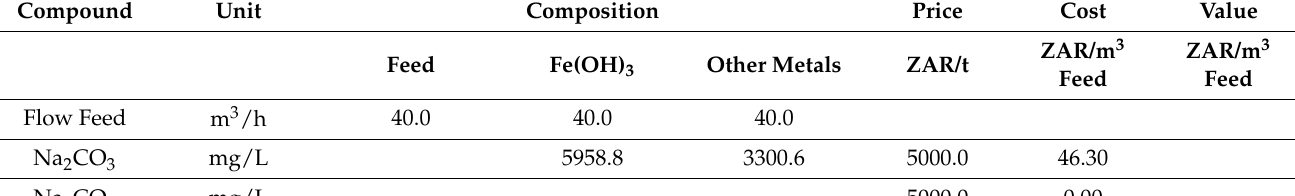
Table 10. Chemical cost and water quality when acid mine water is treated with Na 2 CO 3 for removal of Fe 3+ , Al 3+ , Fe 2+ , Mn 2+ and Ca 2+